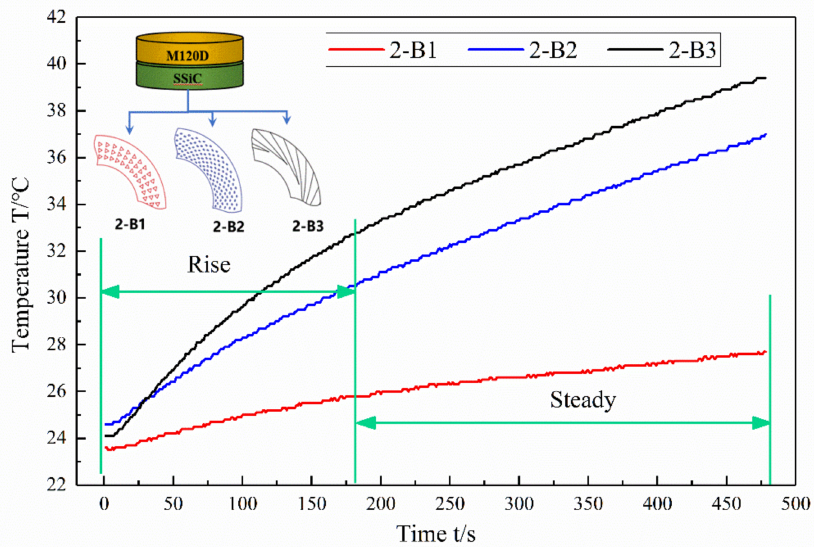
Figure 7. Surface temperature of friction pairs with single texture patterns under 250 rpm.